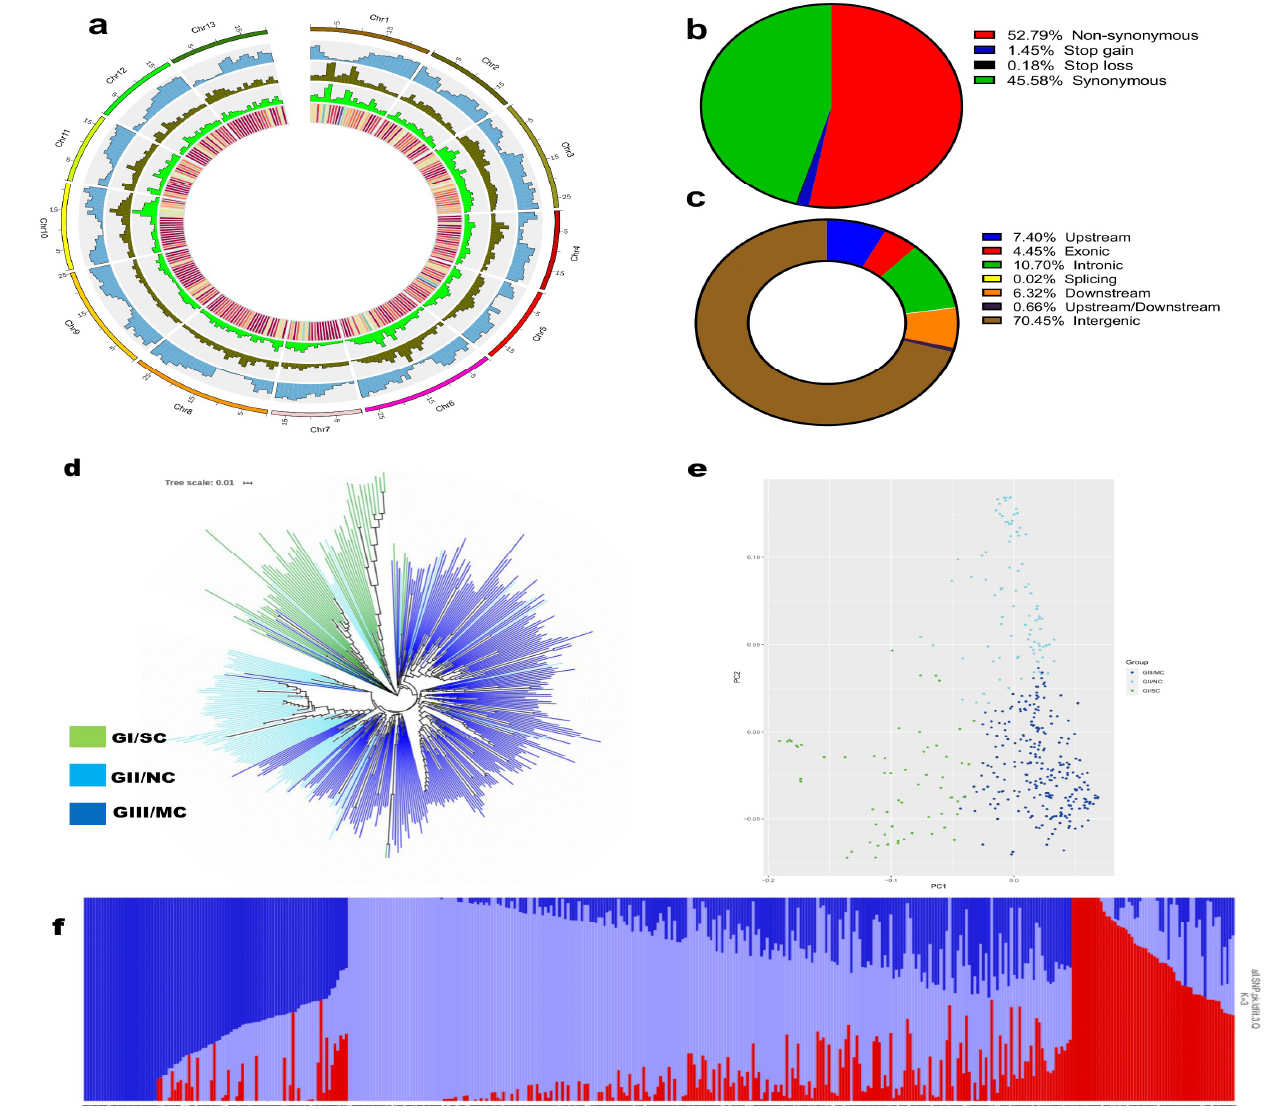
Figure 1. Population structure of sesame accessions in this study. ( a ) Chromosomal distribution of the genomic variants. From the outer to the inner are chromosomes, gene density, SNP density, InDels density, and nucleotide diversity. ( b , c ) Classification of the SNPs. ( d ) Phylogenetic tree of all accessions inferred from whole-genome SNPs filtered by linkage disequilibrium (LD) r 2 < 0.05; The three major groups (Southern cluster, SC; Northern cluster, NC; and middle or central cluster MC) are colored in purple, light blue, and blue, respectively. ( e ) Principal component analysis (PCA) plot for all the sesame accessions; dot colors correspond to the phylogenetic tree grouping. ( f ) Population stratification based on STRUCTURE for K = 3. Each color represents one ancestral population. Each accession is represented by a bar, and the length of each colored segment in the bar represents the proportion contributed by that ancestral